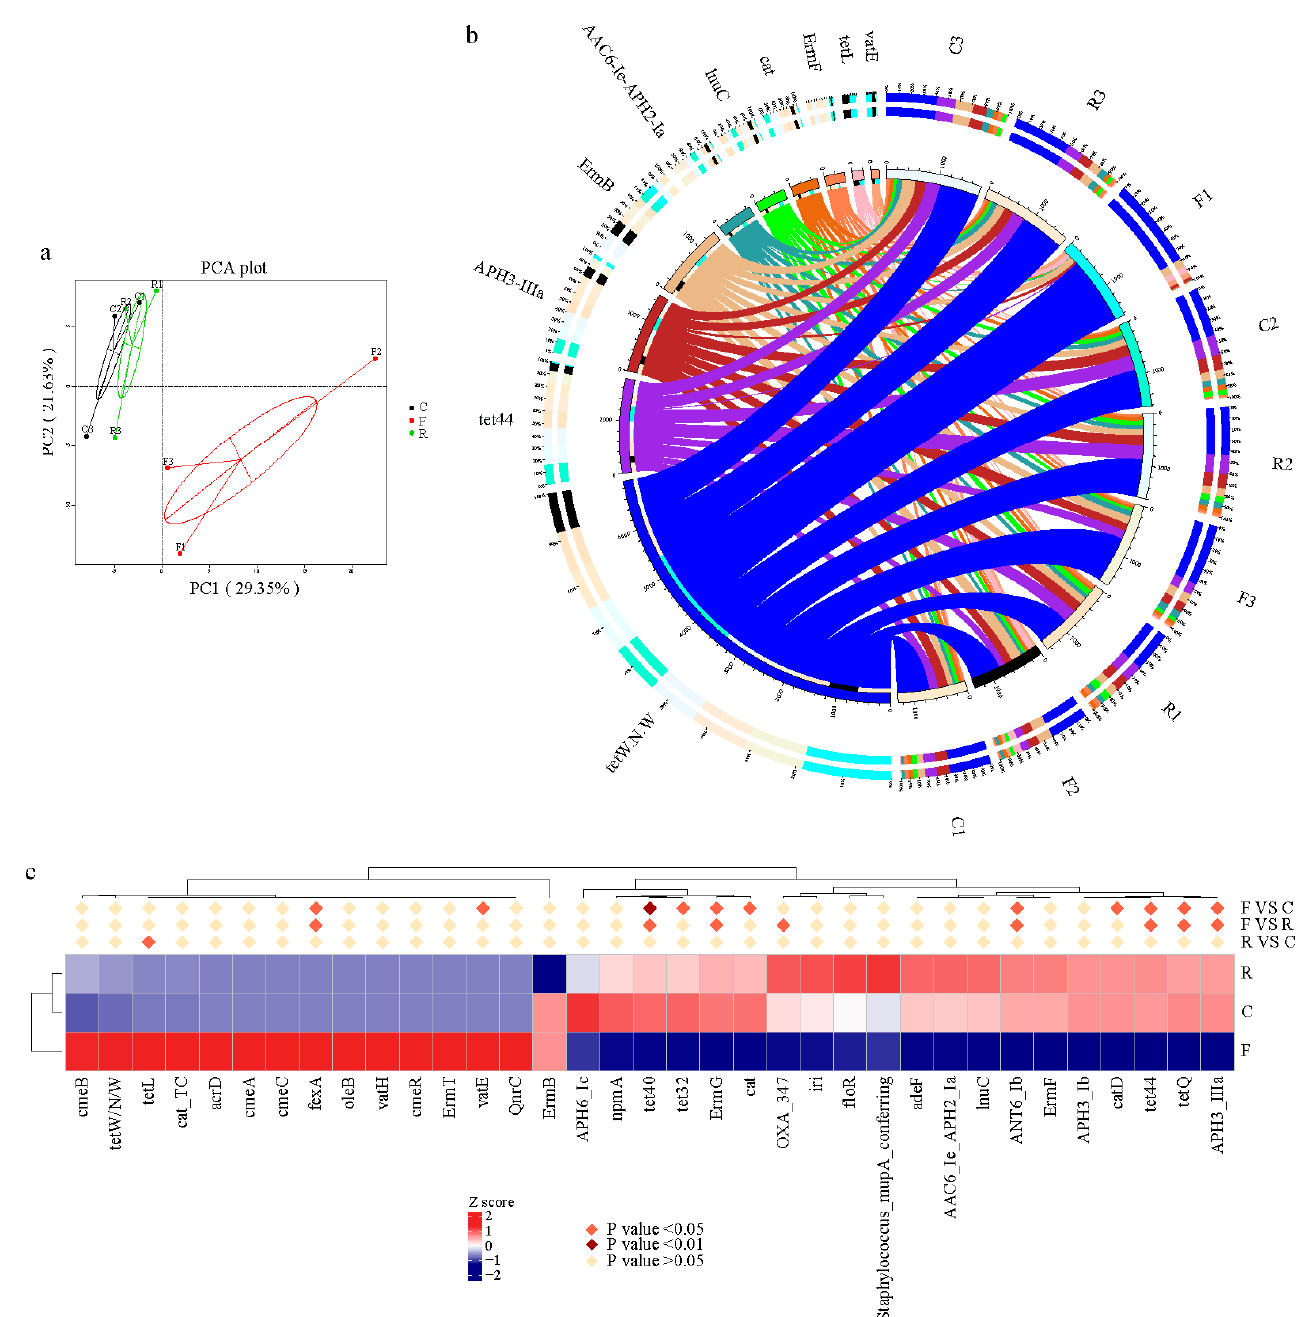
Figure 3. Variations of Antibiotic Resistance Ontology (ARO) subtypes in different sampling resources. ( a ) Principal component analysis of AROs. ( b ) Percentages of AROs in each sample: tet , tetracycline; APH3 , phosphorylation of 2-deoxystreptamine aminoglycosides on the hydroxyl group at the 3 ′ position; ErmB , Erm 23S ribosomal RNA methyltransferase; AAC6 , antibiotic inactivation of APH2 ; LnuC , lincosamide nucleotidyltransferase; cat , chloramphenicol acetyl- transferase; ErmF , Erm 23S ribosomal RNA methyltransferase; vatE , streptogramin vat acetyltransferase. ( c ) Heatmap of variations of AROs based on the relative abundance of AROs. Statistically significant differences among different sampling resources are shown by different colors. F, feces; C, cecal chyme; R, rectal chyme (inner cloacal